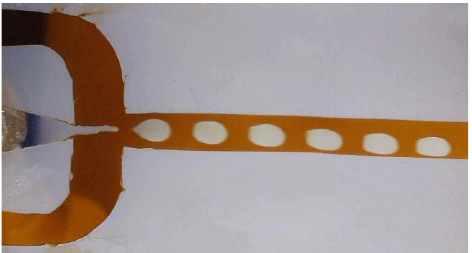
Figure 4. Formation of emulsions in ESCARGOT chip with silicone walls (Fig ure 2c): ( a ) direct; ( b ) inverse.